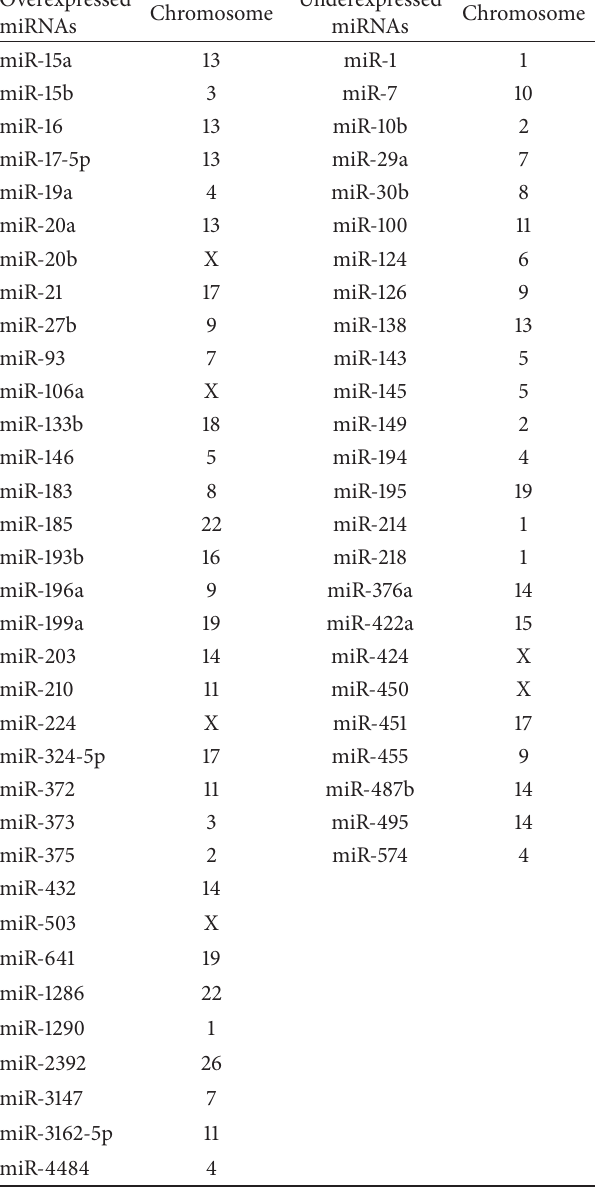
Table 1: Expression of microRNAs in cervical cancer cell [1, 4, 38].